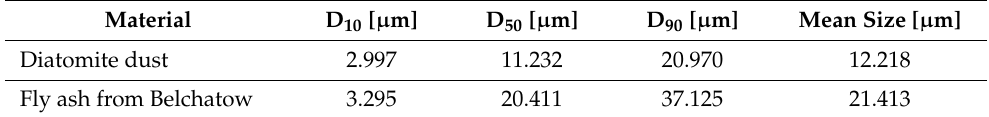
Table 1. Particle size